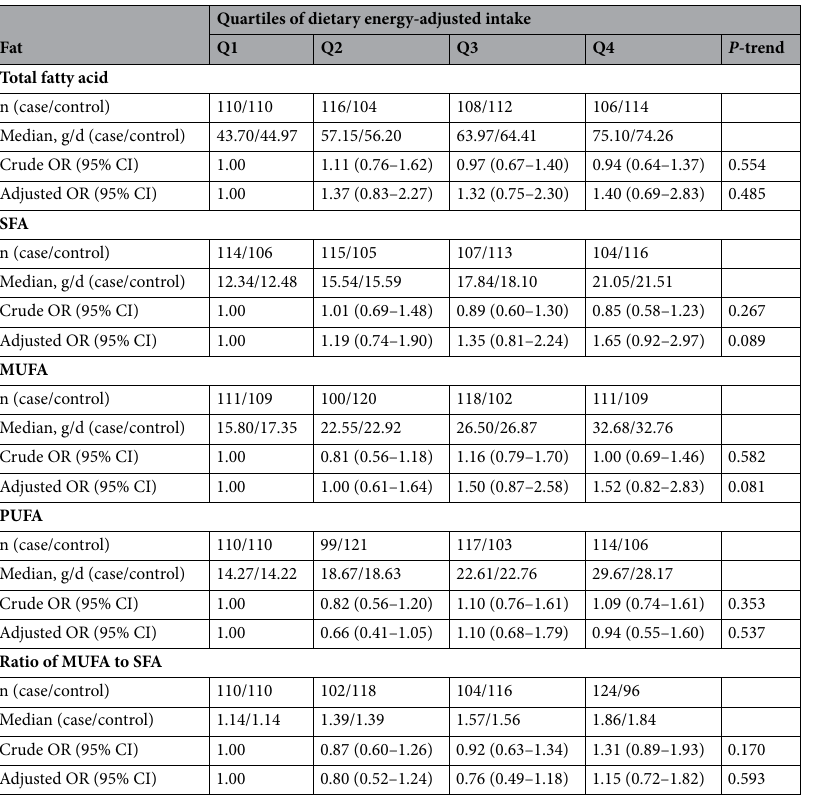
Table 3. Risk of preeclampsia during pregnancy according to quartiles of dietary fatty acids intake. Abbreviation: OR, odds ratio; CI, confidence interval; SFA, saturated fatty acids; MUFA, mono-unsaturated fatty acids; PUFA, polyunsaturated fatty acids. Crude and adjusted OR (95% CI): from conditional logistic model. Covariates includes age, gestational weeks, education level, household income, pre-pregnancy body mass index, alcohol drinking, passive smoking, use of multivitamin, use of folic acid supplement, daily energy intake, carbohydrate intake and total cholesterol intake by enter